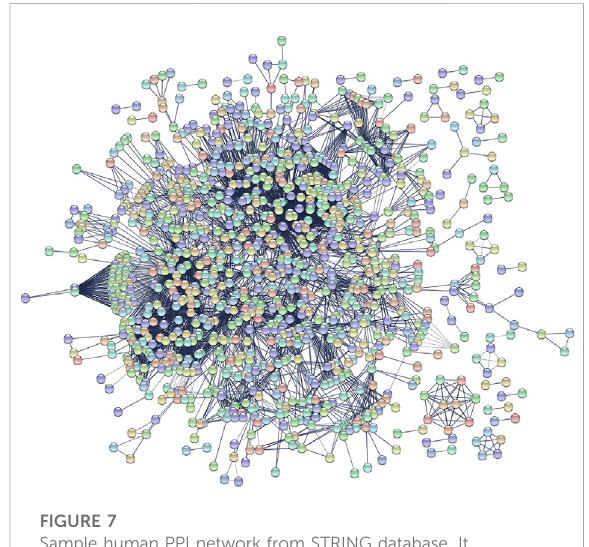
FIGURE 7 Sample human PPI network from STRING database. It consists of nodes and interactions between them.